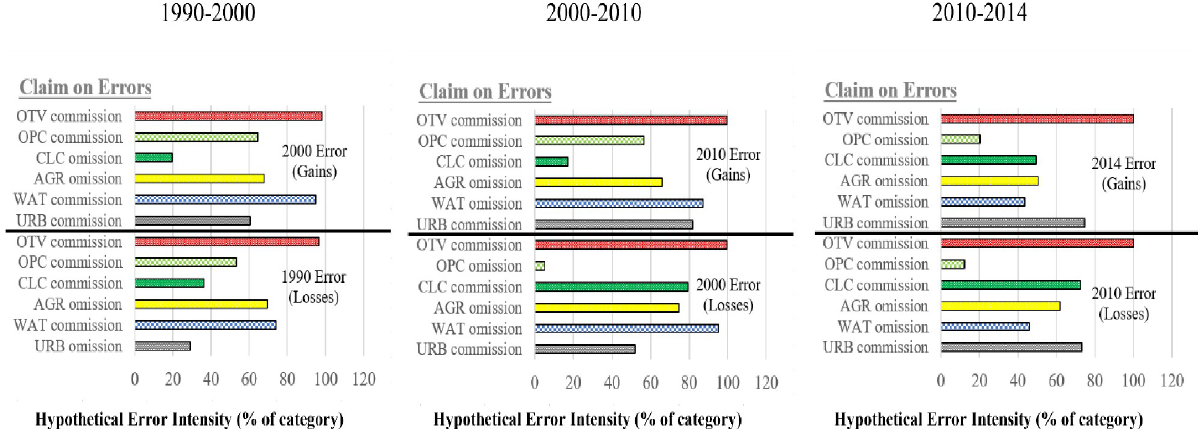
Fig 7. Intensities of errors in the change area that may account for deviations from uniform class gains and losses. In the event that the real intensities of errors are not greater than the values in indicated, it evidences the non-uniformity of the gains and losses at the category level.